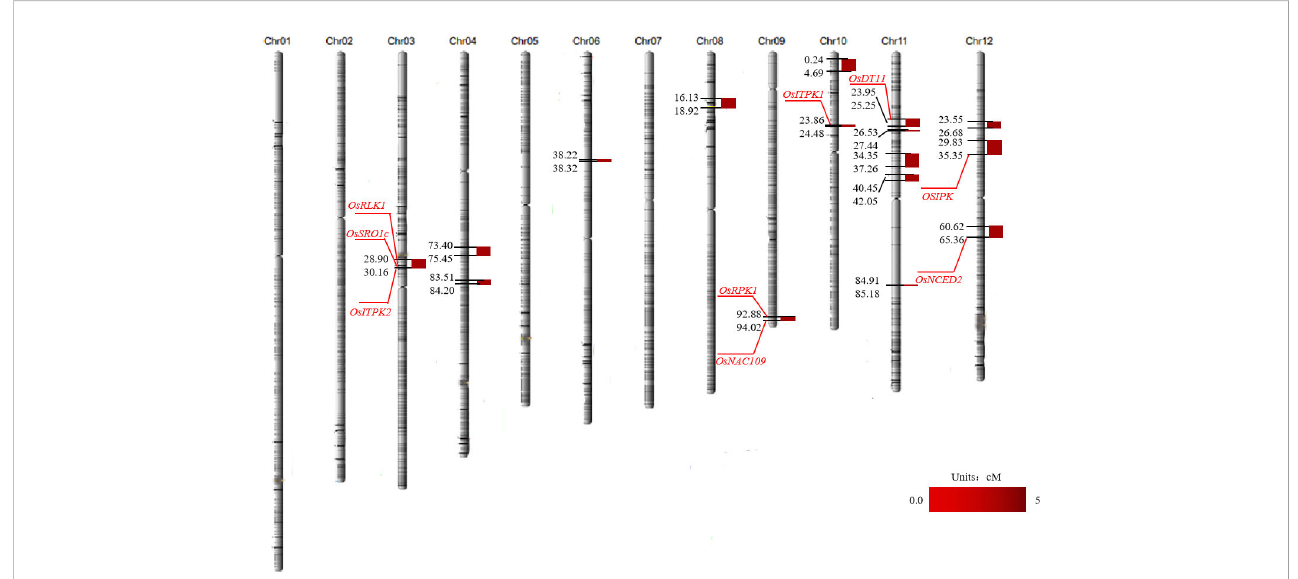
FIGURE 3 Mapping of QTL for salt tolerance in rice. The red gene number is the cloned salt tolerance gene screened in the salt tolerance interval.